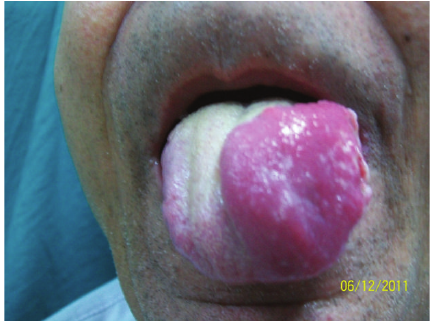
Figure 1: Photograph showing hemimacroglossia.